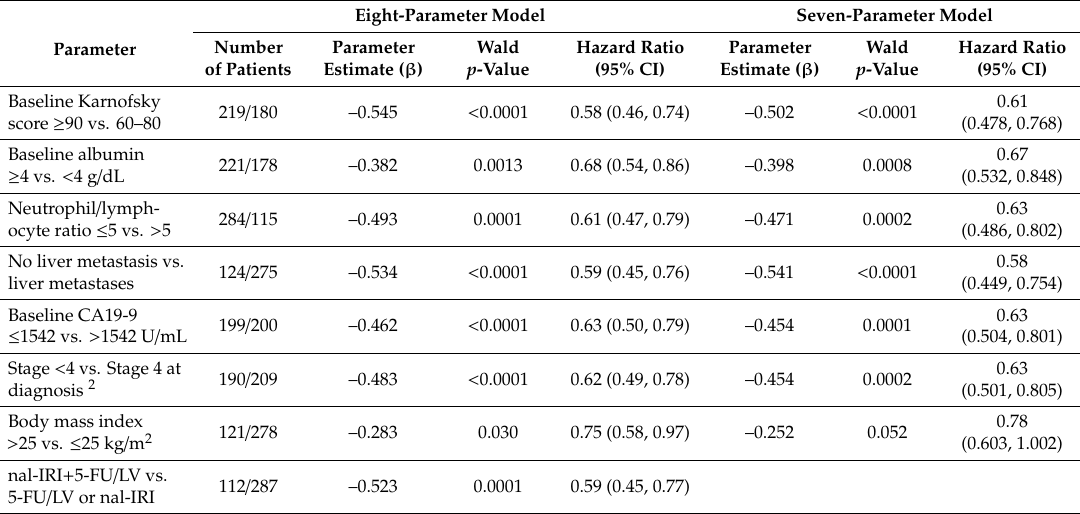
Table 2. Multivariate Cox regression of overall survival ( N = 399) 1